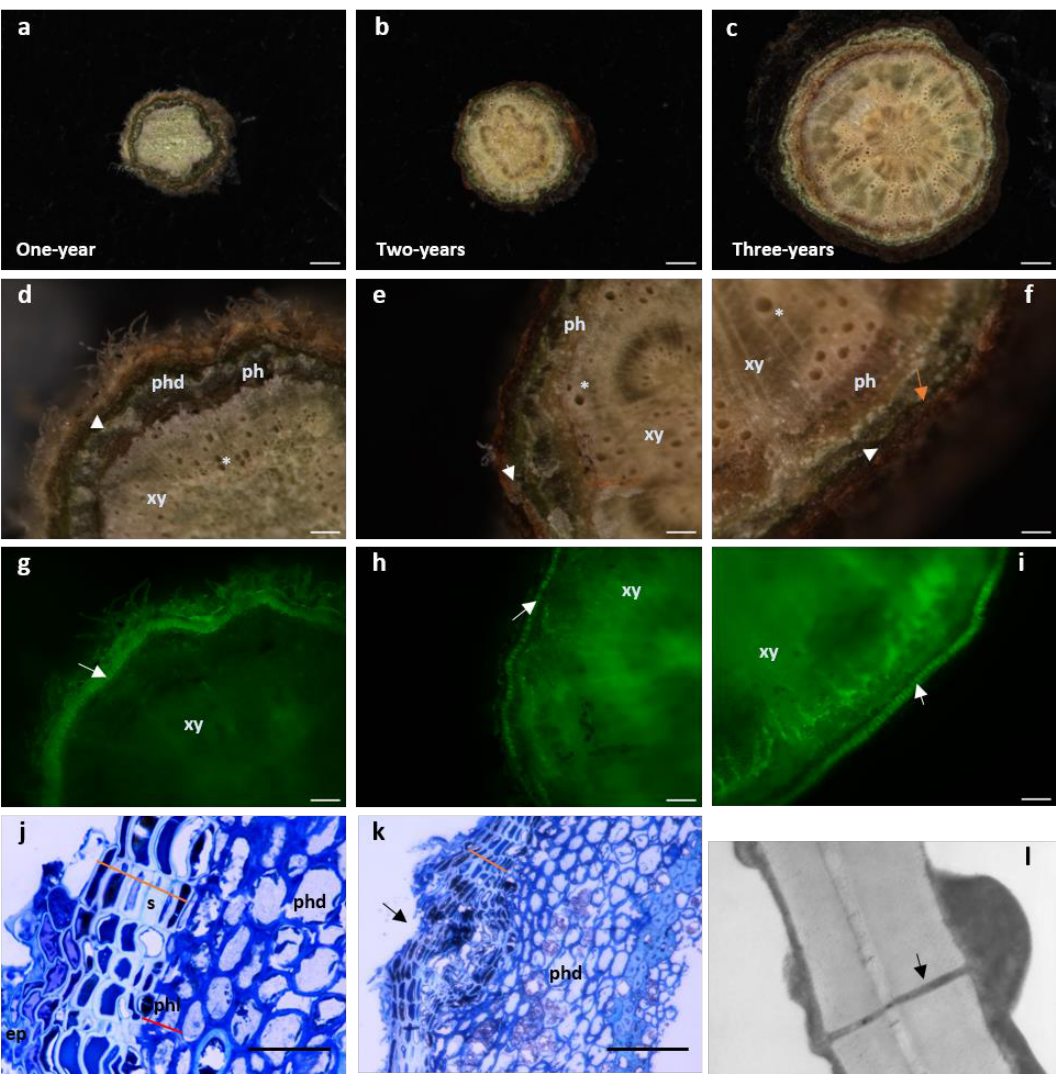
Figure 2. Cork develops as early as one-year stems in Quercus suber . ( a – i ) Cross-sectional stere- omicroscopic images of one-, two- and three-year-old stems. (Scale bars: ( a , b ) 100 µ m, ( c ) 500 µ m). ( d – f ) Details of the xylem with empty tracheids ( * ). Moving outwardly, one finds the phloem (dark layer) surrounded by the periderm comprising the phelloderm (orange arrow - phd ), a thin layer